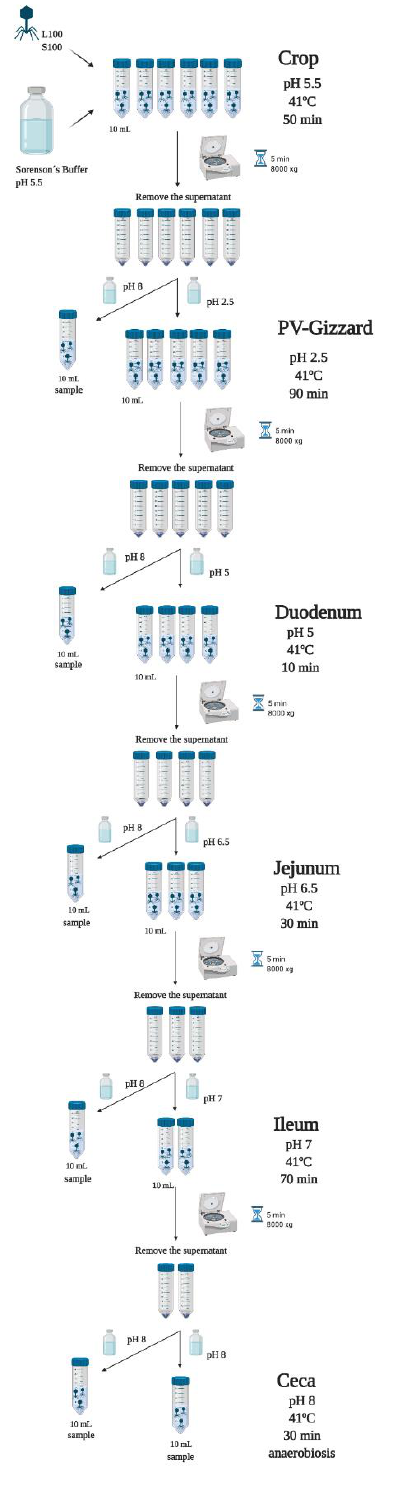
Figure 4. Scheme of the in vitro assay simulating the broiler GIT to assess the encapsulation maintenance (L100 and S100) along the GIT. The transit-time, temperature and pH of the crop (pH 5.5), proventriculus-gizzard (pH 2.5), duodenum (pH 5), ileum (pH 6.5), jejunum (pH 7), and ceca (pH 8 in anaerobiosis) were simulated. L100: encapsulated BP with the polymer Eudragit ® L100; S100: encapsulated BP with the polymer Eudragit ® S100. Created with BioRender.com.